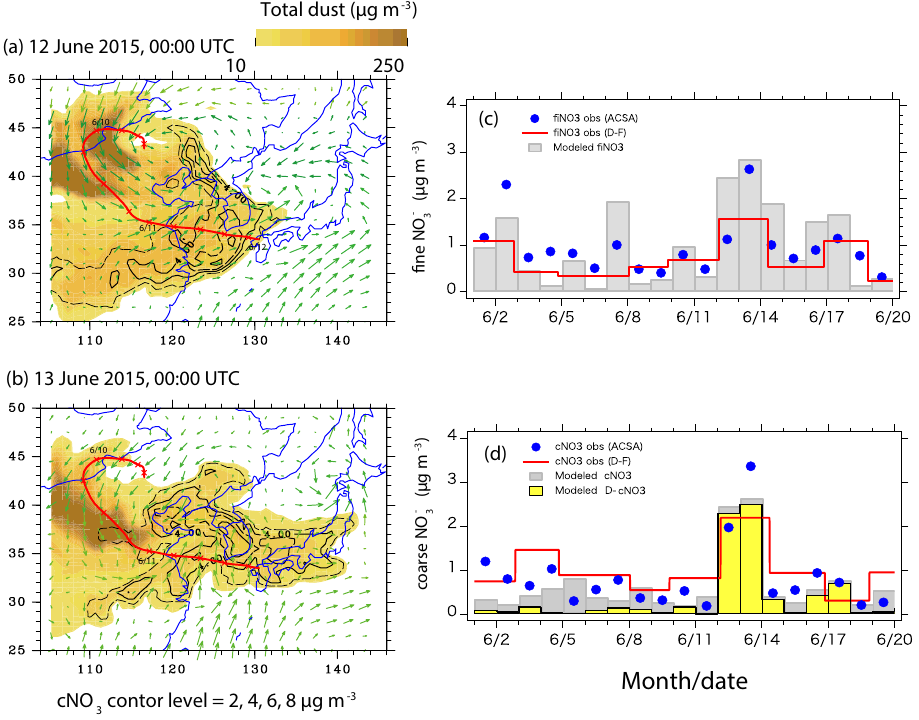
Figure 5. Horizontal distribution of dust (sum of all dust bins) (yellow color) and coarse NO − (b) 13 June, and the time variation of daily average (c) fine NO −